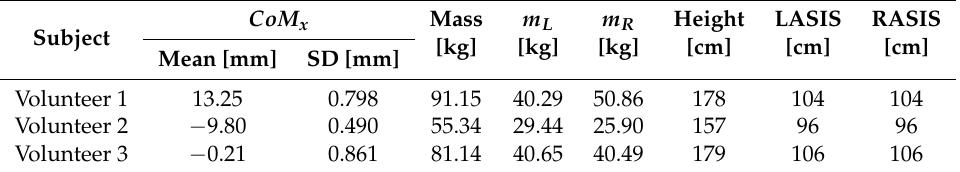
Table 4. Measurement results of the CoM along the x -axis ( CoM x ), mass, loads on the left ( m L ) and right ( m R ) legs, the positions of the LASIS and RASIS anatomical points for three chosen volunteers.